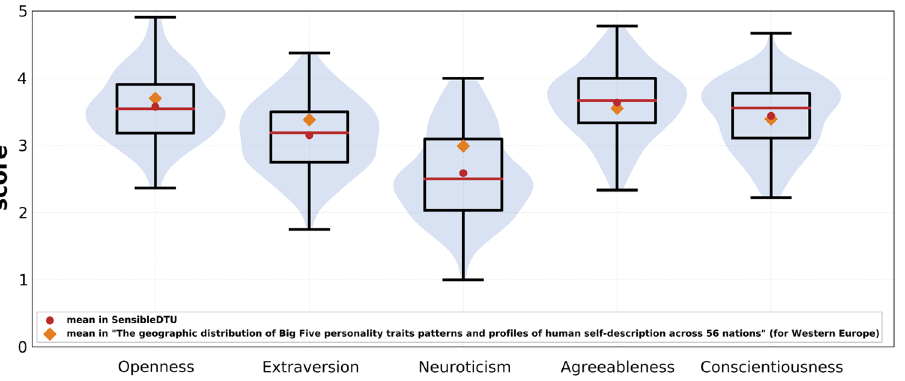
Figure 14. Personality traits. Violin plot of personality traits. Summary statistics are: openness m O ~ 3 : 58 , s O ~ 0 : 52 ; extraversion m E ~ 3 : 15 , s E ~ 0 : 53 ; neuroticism m N ~ 2 : 59 s N ~ 0 : 65 ; agreeablenes m A ~ 3 : 64 s A ~ 0 : 51 ; conscientiousness m C ~ 3 : 44 s C ~ 0 : 51 . Mean values from our deployment (red circles) compared with mean values reported for Western Europe (mixed student and general population) [170] (orange